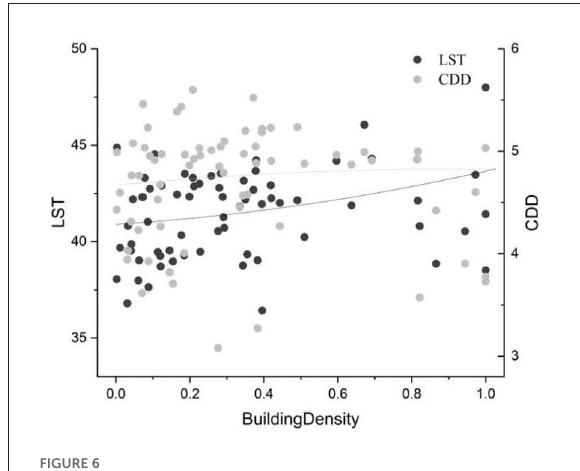
FIGURE6 Correlation between LST (CDD) and building density (LST unit: ◦ C).